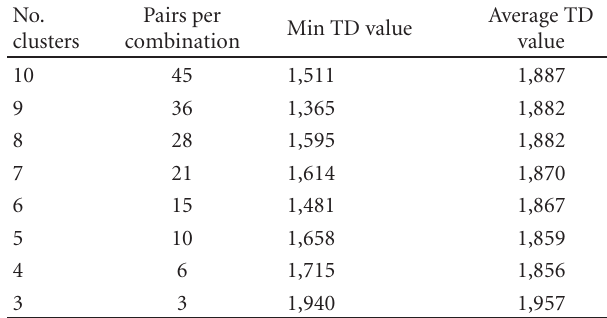
Table 3: Transformed Divergence (TD) values for iterative assess- ment of spectral signatures to distinguish soil classes over a 150ha study area on the Chihuahuan Desert Rangeland Research Center in southern New Mexico. Minimum (Min) and mean TD values were tabulated within the Signature Editor in ERDAS Imagine